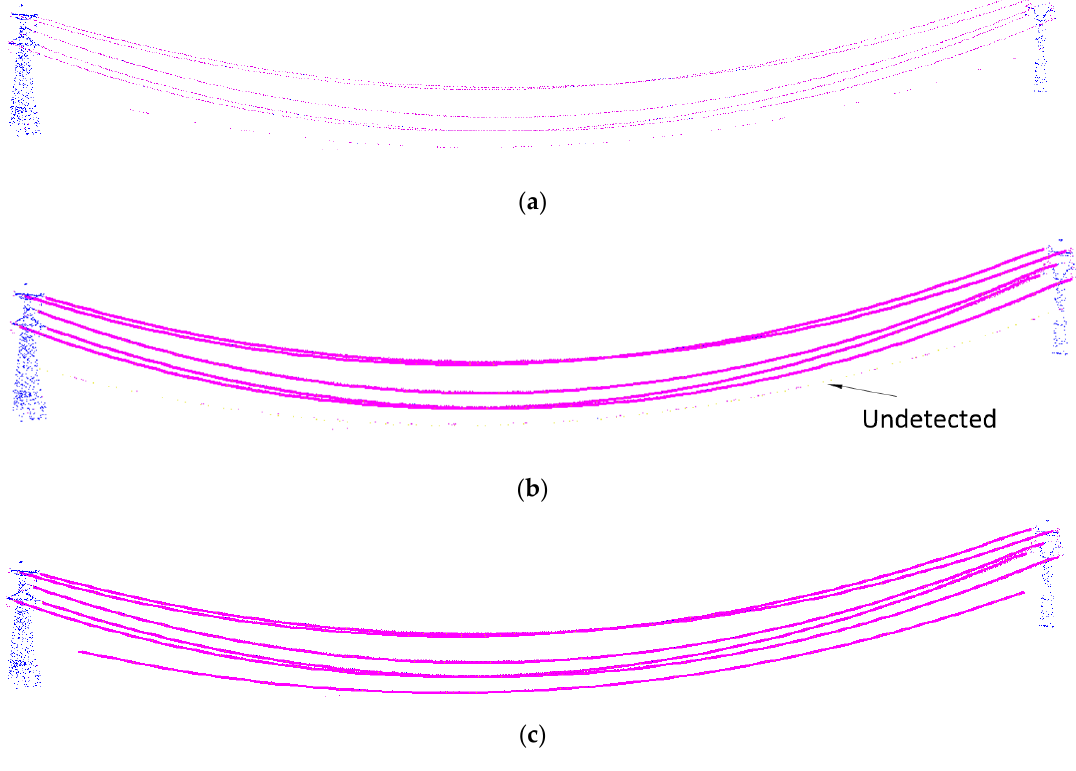
Figure 12. ( a ) Original data; ( b ) reconstruction results using McLaughlin’s method [9]; and ( c ) reconstruction results with our method.